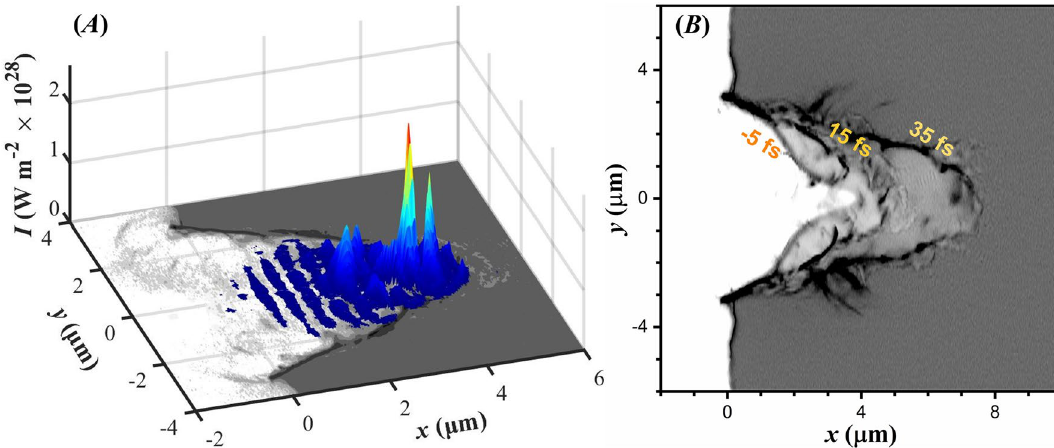
Figure 2. ( A ) Laser intensity (color surface plot) overlaid on the lithium electron number density (grayscale 28 Wm − 2 image) at 15fs , when an intensity of 2.6 × 10 is reached. ( B ) Overlay of three successive electron number density distributions, with a time step of 20fs . The first layer is at − 5 fs , when the main pulse is within the cavity. The overlay of the three layers reveals the temporal dynamics of the cavity formation within the target.